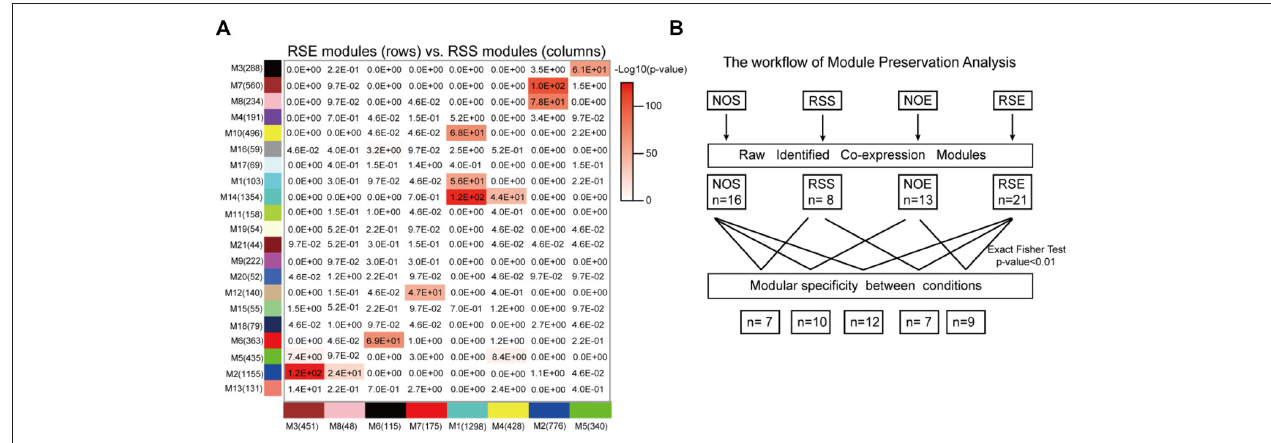
FIGURE 4 | Module specificity and preservation. (A) Perseveration of co-expression networks between RSE and RSS. Each square in the graph represents the degree of overlap between two modules. The number in the cell represents the probability of module preservation between two conditions. A hypergeometric two-tailed Fisher’s exact test was used to determine the probability. (B) Summary of module preservations for all four conditions.